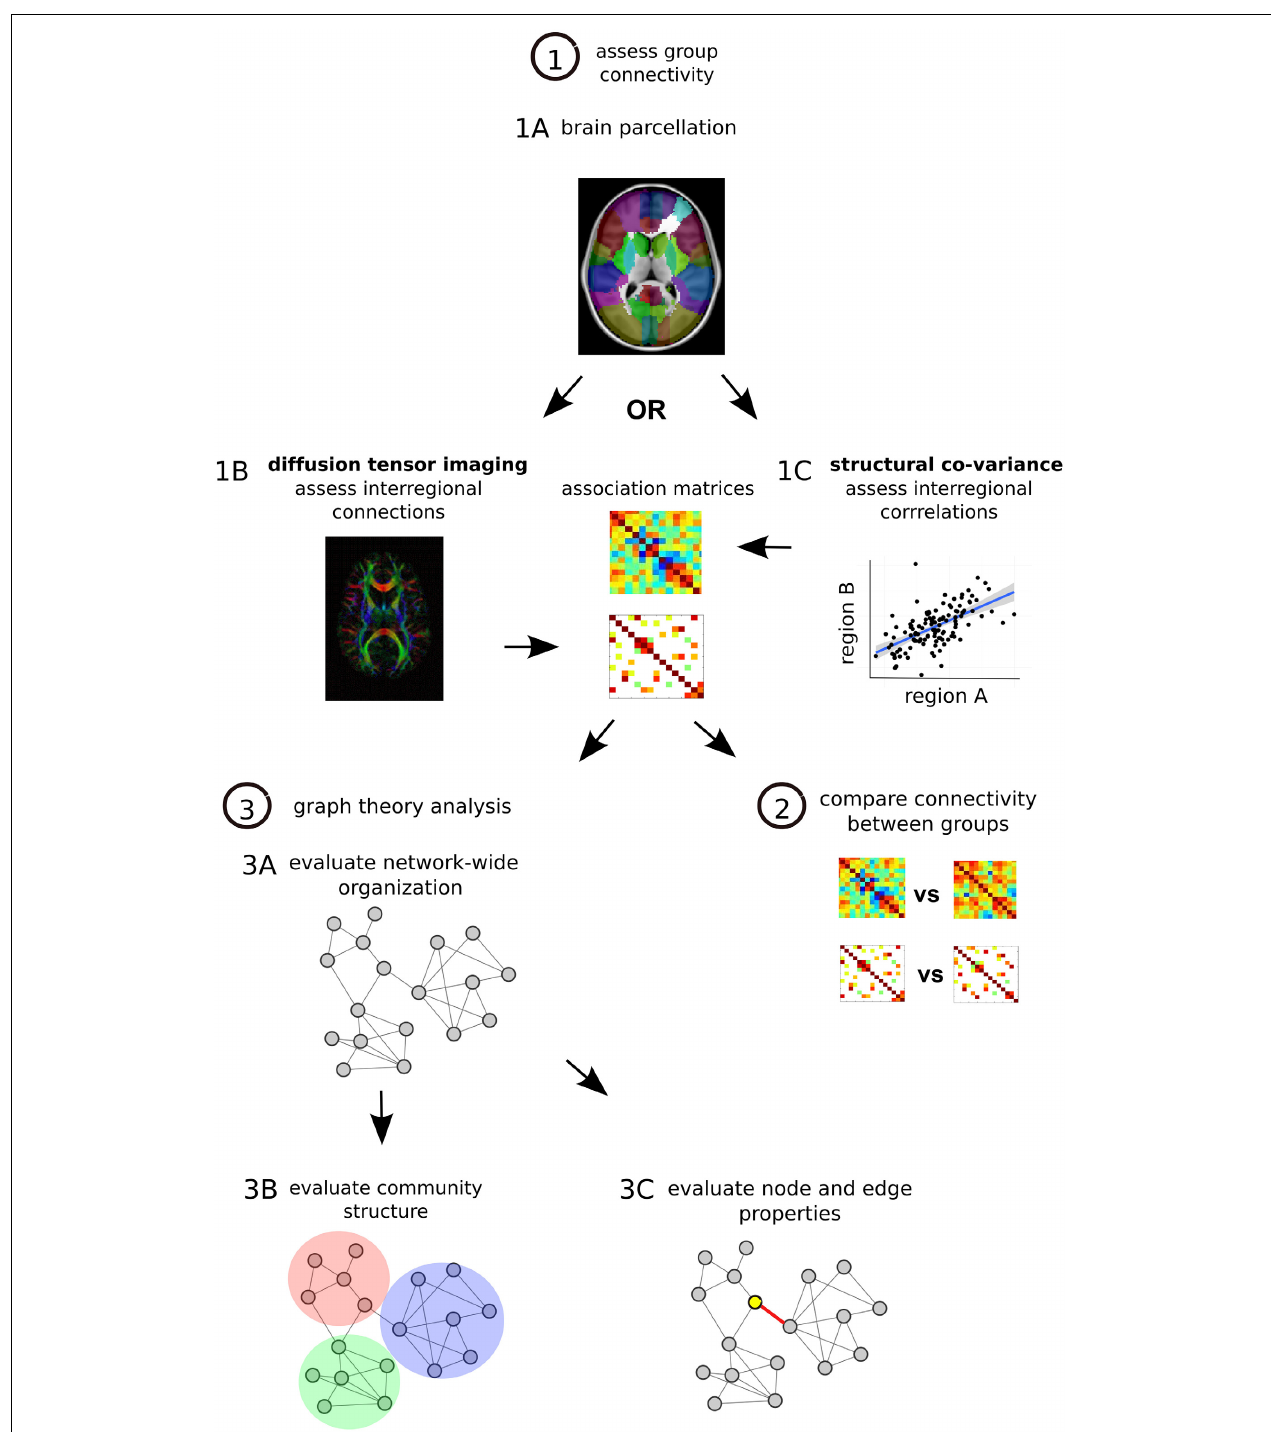
FIGURE 2 | Structural network analysis steps. (1) Assess group connectivity. Perform MRI imaging and parcellate the brain, many different methods can be applied (Craddock et al., 2013) (1A) . Quantify DTI-based structural connectivity or morphometry-based structural co-variance throughout the brain. For DTI the presence and strength of interregional connections are assessed, one matrix is generated for each subject and then a group average is calculated (1B) . For structural co-variance analysis between-subject correlations in morphology are calculated in each group